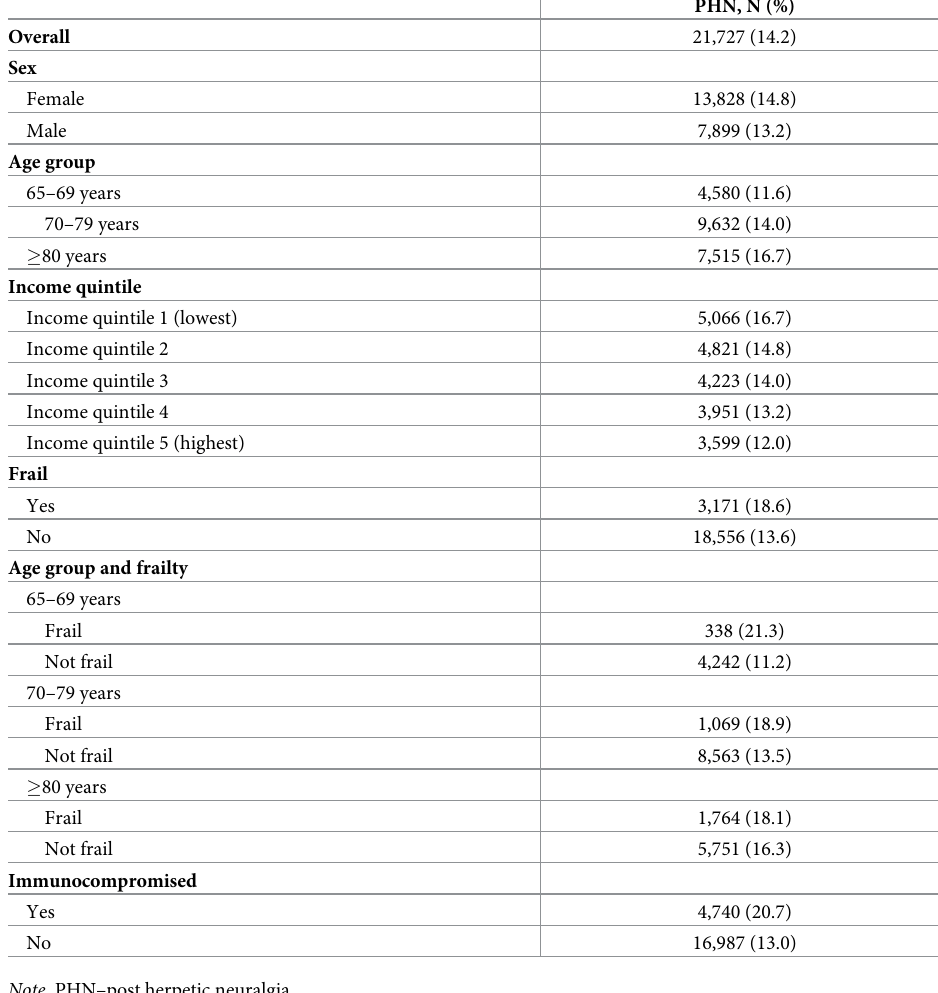
Table 4. Number and proportion who developed post herpetic neuralgia a (between 90–365 days after herpes zos- ter diagnosis) across study